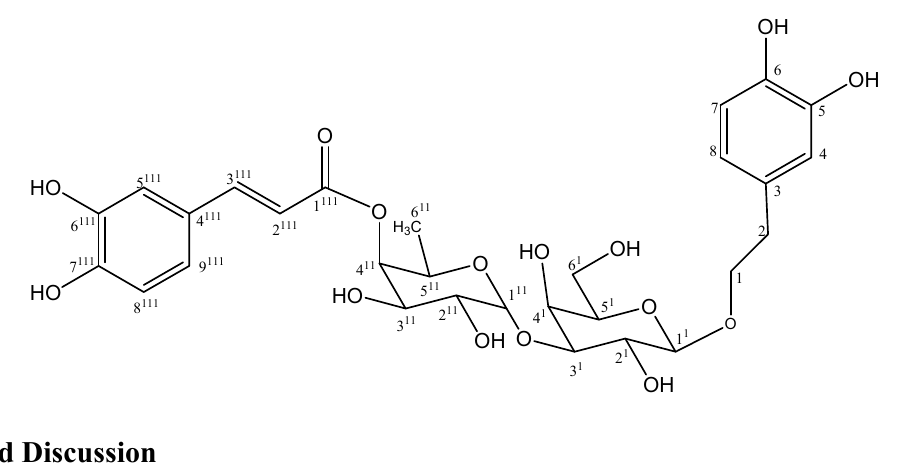
Figure 4. Structure of compound 6